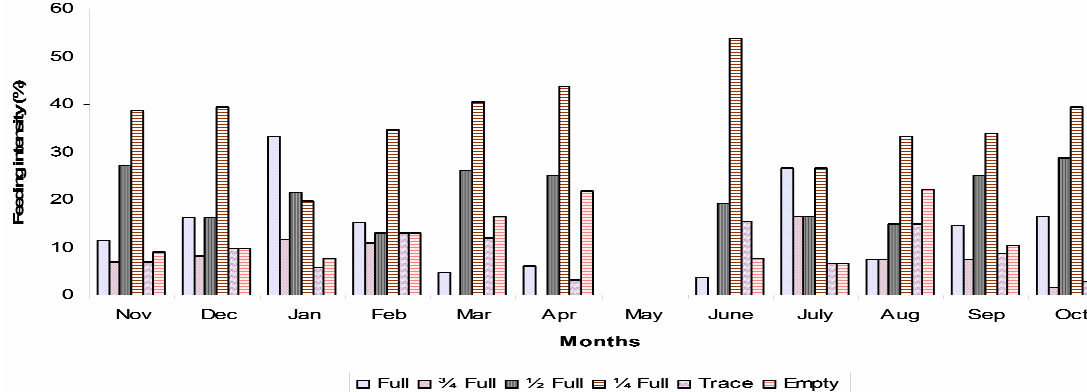
Fig. 8. Month-wise feeding intensity in males of S. melantho